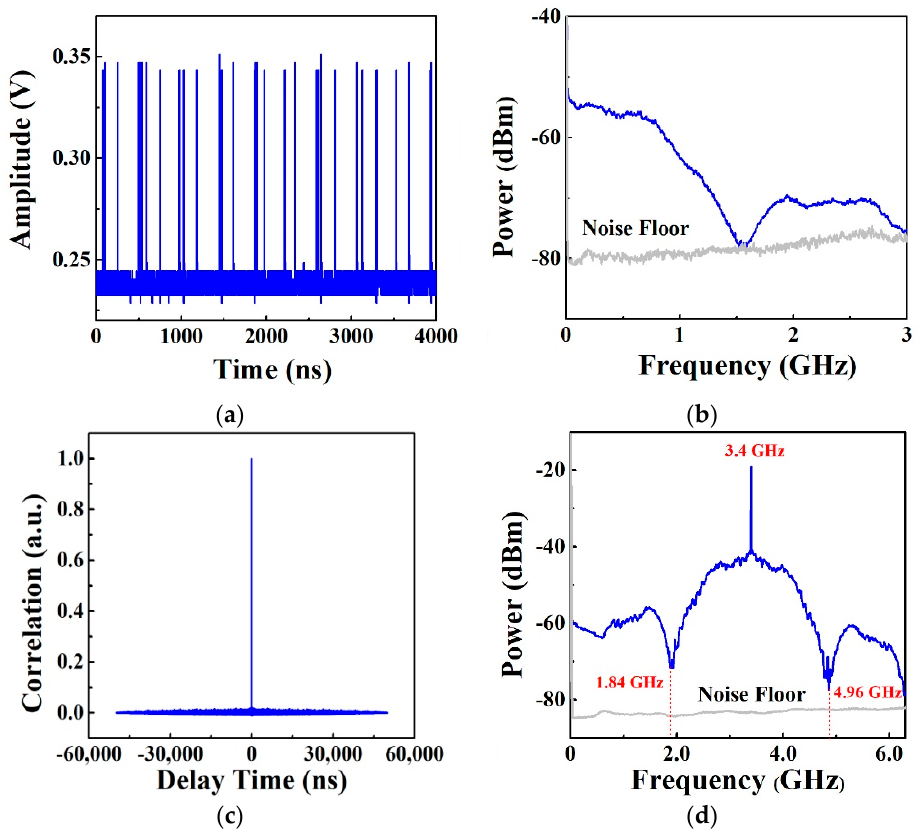
Figure 2. ( a ) Time series, ( b ) Power spectrum, and ( c ) auto-correlation trace of the probe signal, ( d ) power spectrum of the up-converted chaotic pulse position modulation (CPPM) signal as the transmitting signal.